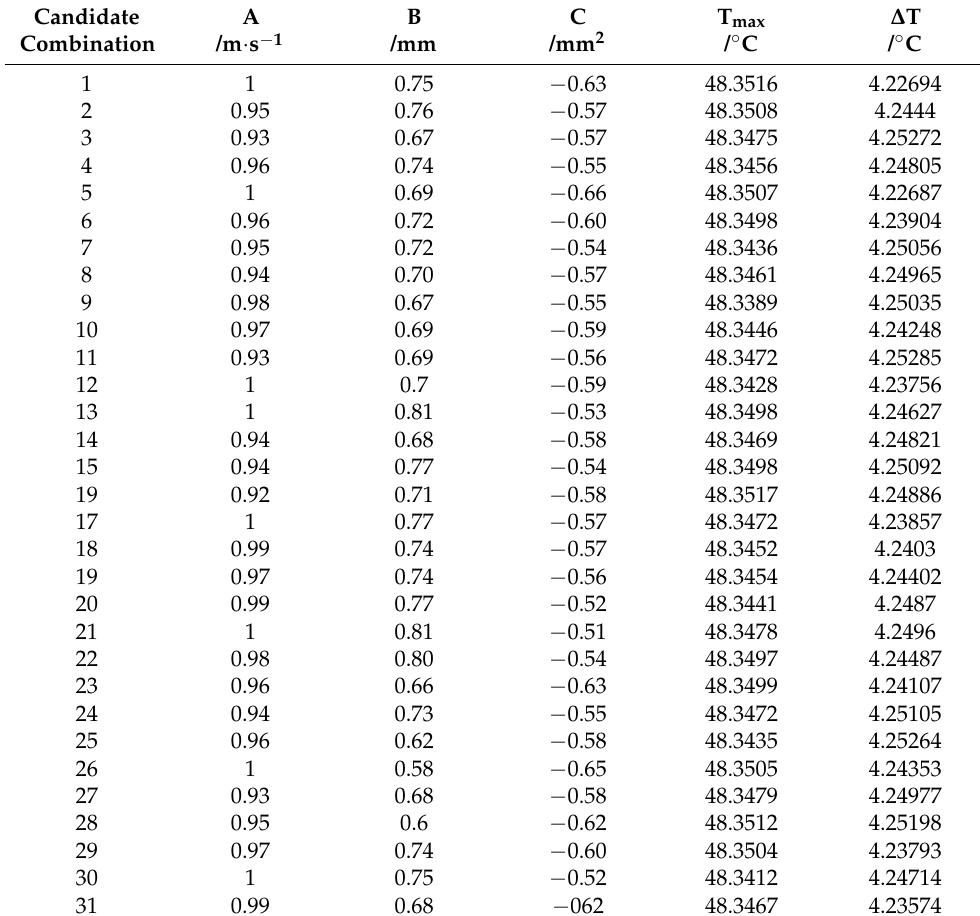
Table 5. The candidates of the battery module.